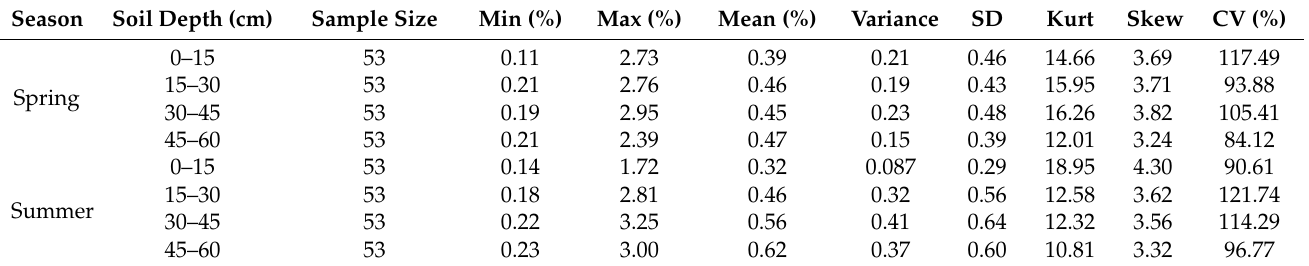
Table 3. Descriptive statistical characteristics of soil salinity in different seasons and